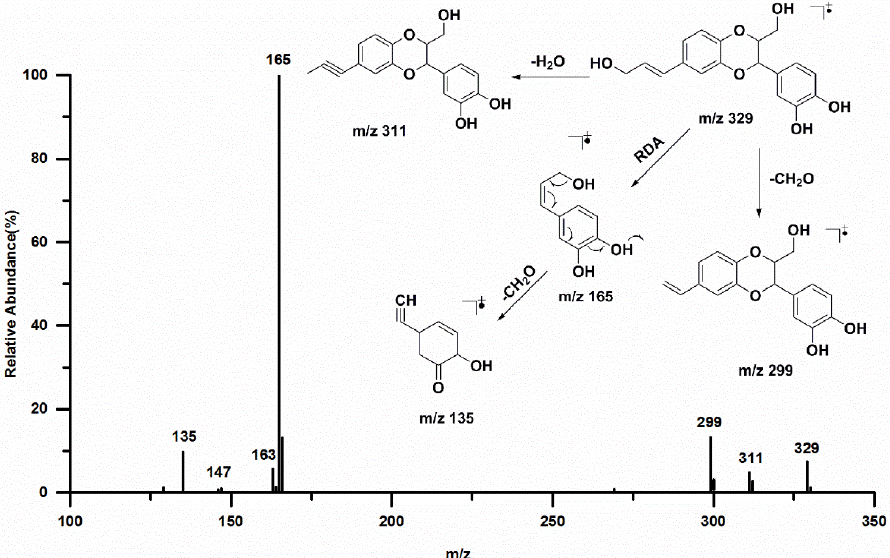
Figure 2. The fragmentation pathways based on the MS/MS spectra of isoamericanol A. Compounds 1 and 5 were detected at t R 0.68 and 12.59 min with similar deprotonated molecular ion [M-H] − of m/z 329 and MS spectral data, which indicated that they were the isomers. Two distinguished fragments at m/z 329 and m/z 137 were generated by deproto- nation or the cleavage of the furan ring. The fragment ions at m/z 299 and m/z 269 indicated the continuous release of the CH 2 O group from [M-H] − and [M-H-CH 2 O] − . A characteristic ion can be seen at m/z 165 due to the RDA cleavage. The MS data were in agreement with those previously reported, and compounds 1 and 5 were identified as (+)-7-epi-sesamin- dicatechol and (±)-3,3′-bisdemethylpinoresinol, respectively [22,23]. Compound 12 displayed a deprotonated molecular ion [M-H] − of m/z 327 at t R 21.39 min, which was 2 Da (2 hydrogens) less than americanol A and isoamericanol A. The frag- ment at m/z 297 was attributed to the neutral loss of CH 2 O. Typical fragment ions of com- pound 12 were obtained at m/z 165, m/z 163, m/z 147, and m/z 135, which were similar